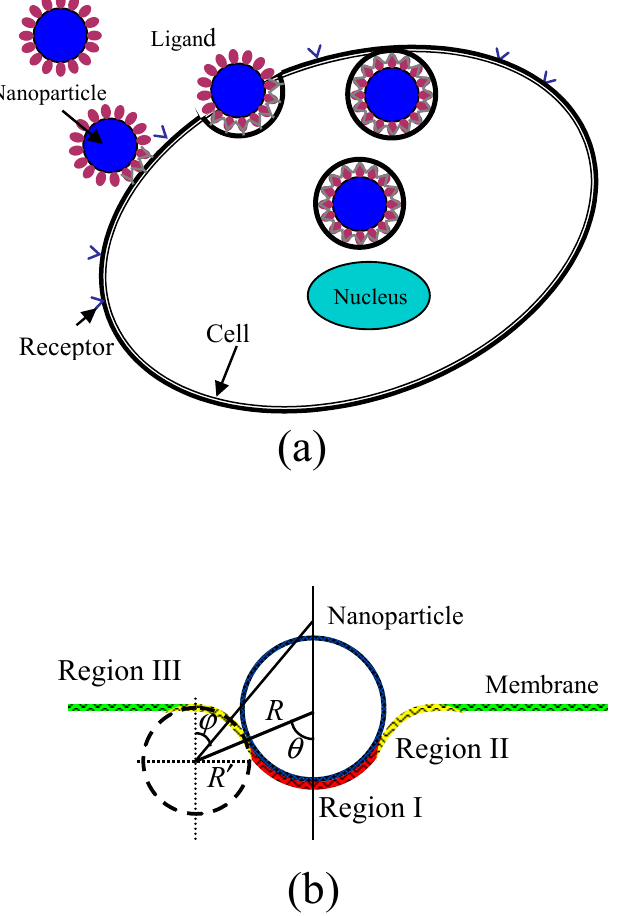
Figure 1. ( a ) Schematic illustration of nanoparticles (NPs) internalized by cell membrane to different degrees: away from the membrane, the partially wrapped state and fully wrapped state. ( b ) Schematic geometry of a particle wrapped by an initially flat membrane.